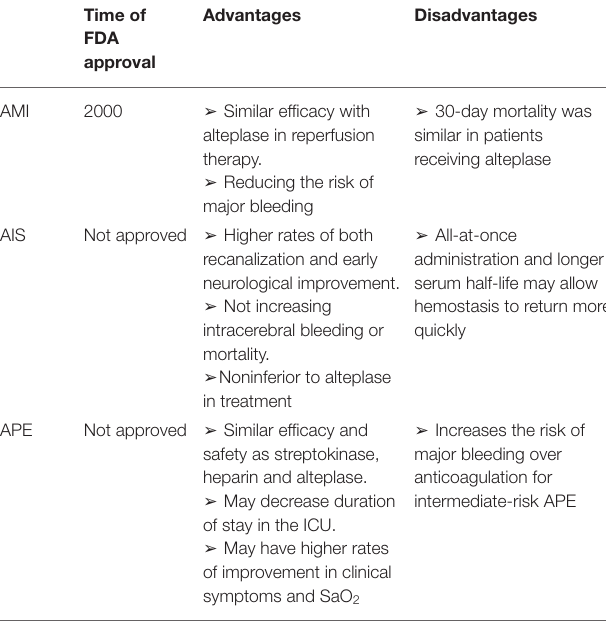
FIGURE 5 | Forest plots of tenecteplase vs. anticoagulation treatment grouped by hemorrhage rates ( < 30 days or ≥ 30 days) for patients with intermediate-risk PE. (excluding Meyer et al. study). TABLE 4 | Tenecteplase therapy in patients with thrombotic diseases. TABLE 5 | The meta-analyses of tenecteplase in patients with thrombotic